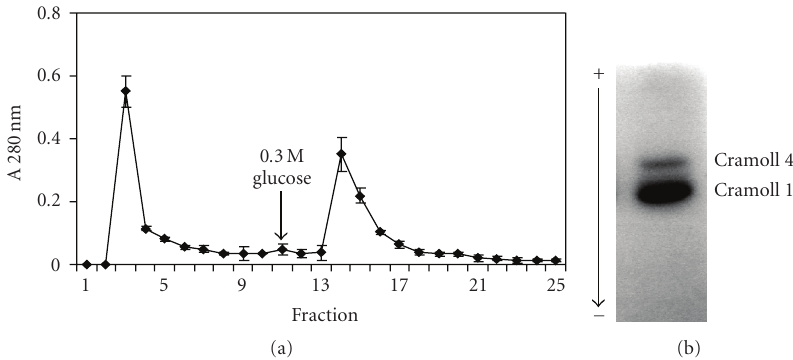
Figure 3: A ffi nity binding of Cramoll 1,4 on FMZAG-12L . An amount of 1.5 mg of Cramoll 1,4 was incubated with the magnetic particles and eluted with bu ff er and glucose afterwards (arrow). (a) Fractions (1mL) were collected and their absorbance at 280nm established (a). Each bar represents the mean ± SD of four experiments using the same FMZAG-12L particles. (b) Electrophoresis to native and basic protein (100 μ g) from the 14th and 15th fractions, stained with Amido Black.